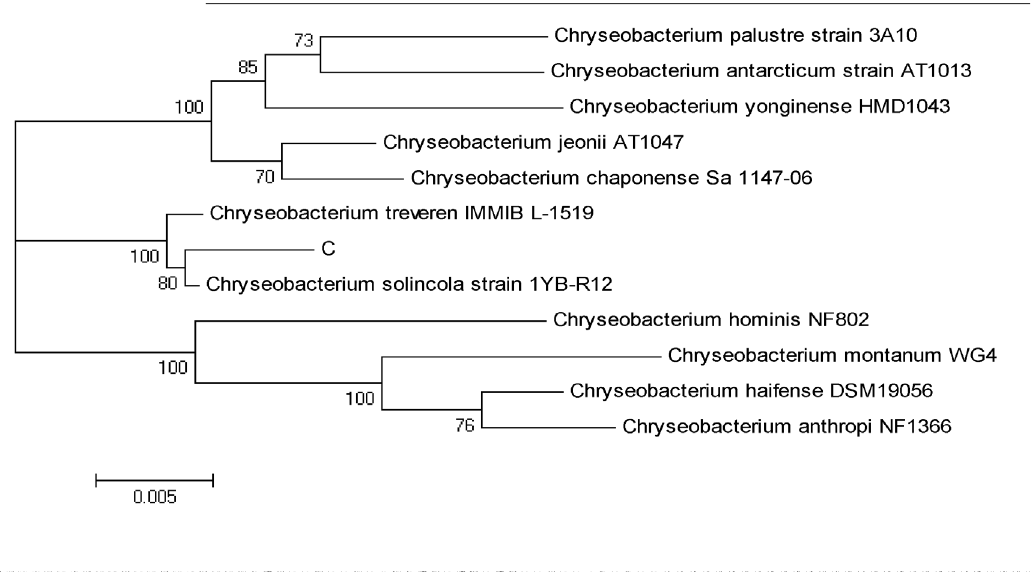
Figure 2: Phylogenetic position of strain C and its closest relatives in the genus, Chryseobacterium , based on 16S rRNA gene sequences.